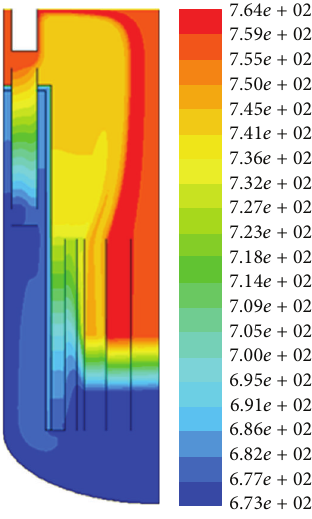
Figure 13: Temperature distribution of SNRLFR-100 primary cool- ing system (in K).